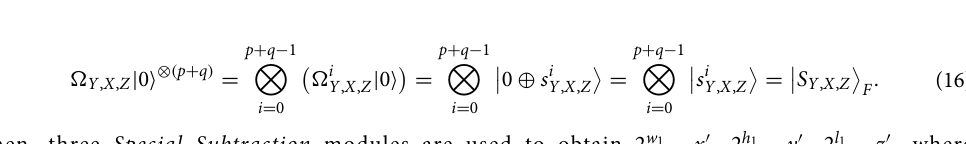
Figure 16. Schematic representation of the scaling-up circuit, where r y = 4 , r x = 2 , r z = 2